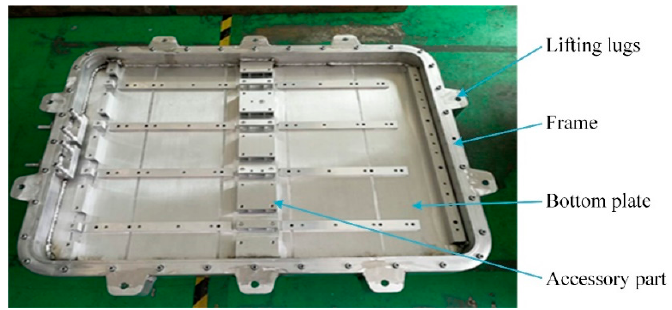
Figure 1. Structure of the power battery enclosure.